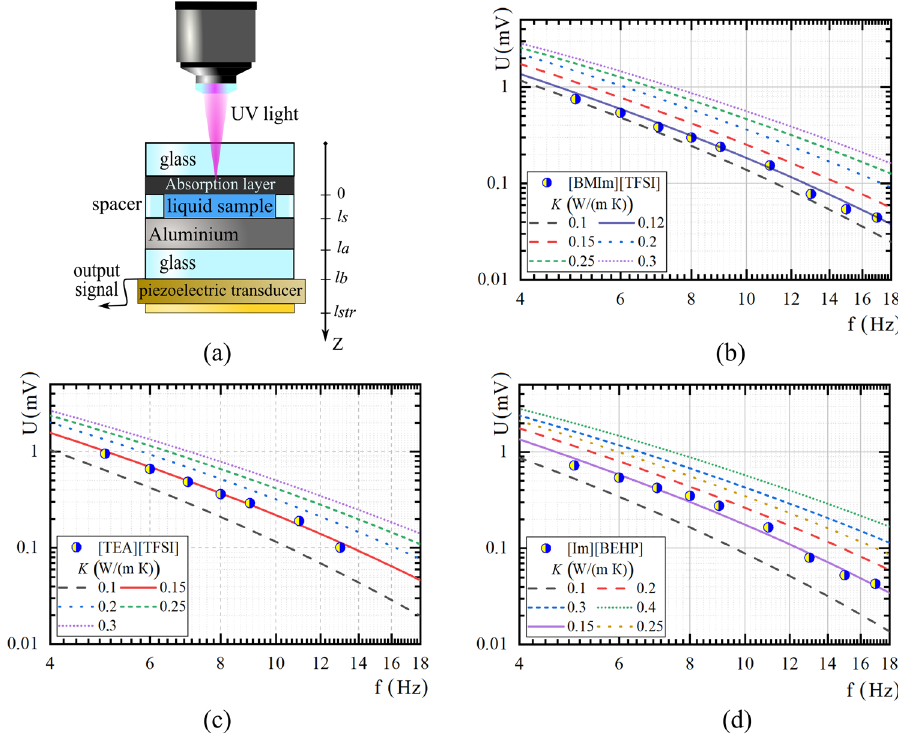
Figure 2. PA cell with piezoelectric registration employed ( a ), amplitude-frequency characteristics of a multilayer system with IL: [BMIm][TFSI] ( b ), [TEA][TFSI] ( c ), [Im][BEHP] ( d ). Circles indicate the experimental data, lines—the simulation of PA signal formation at different values of thermal conductivity of the liquid